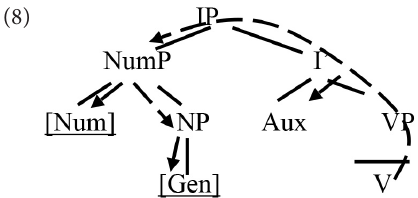
The long-dashed line with arrows represents the direction of search for a gender and number